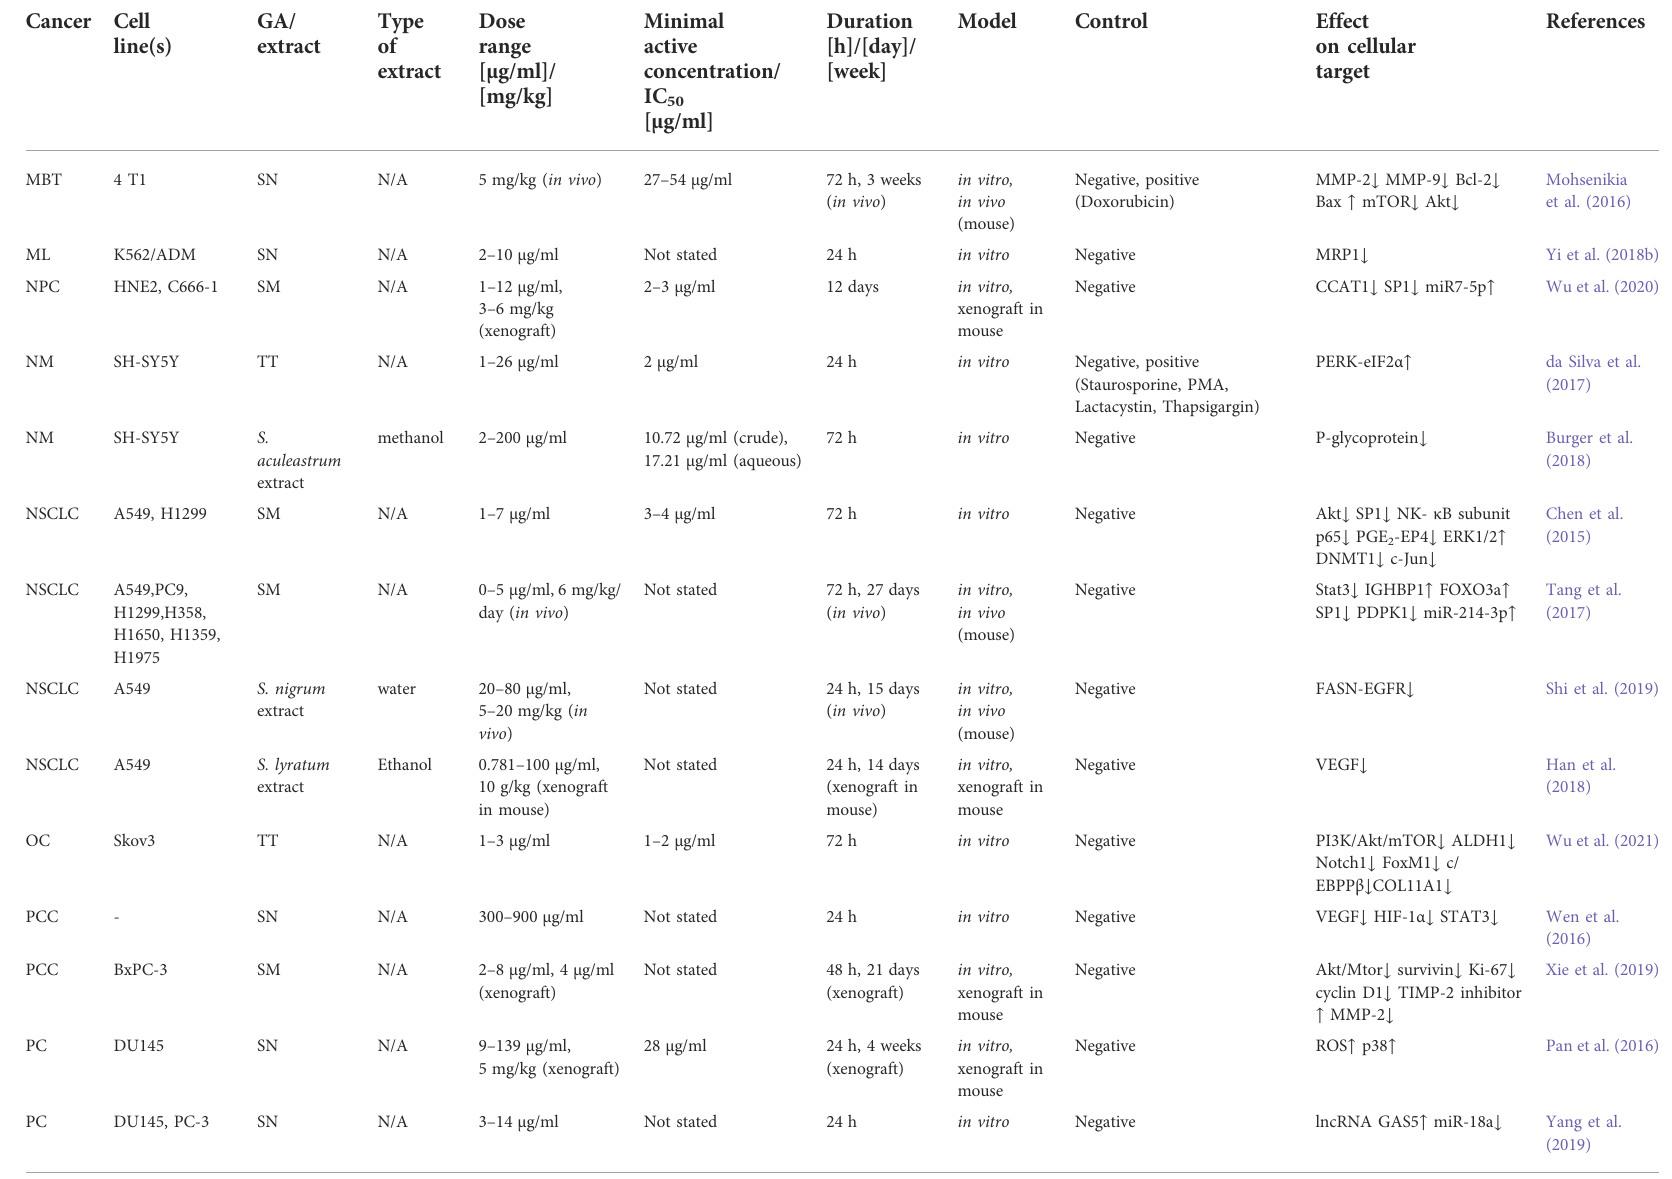
TABLE 1 ( Continued ) Effect of GAs on cellular targets in cancer